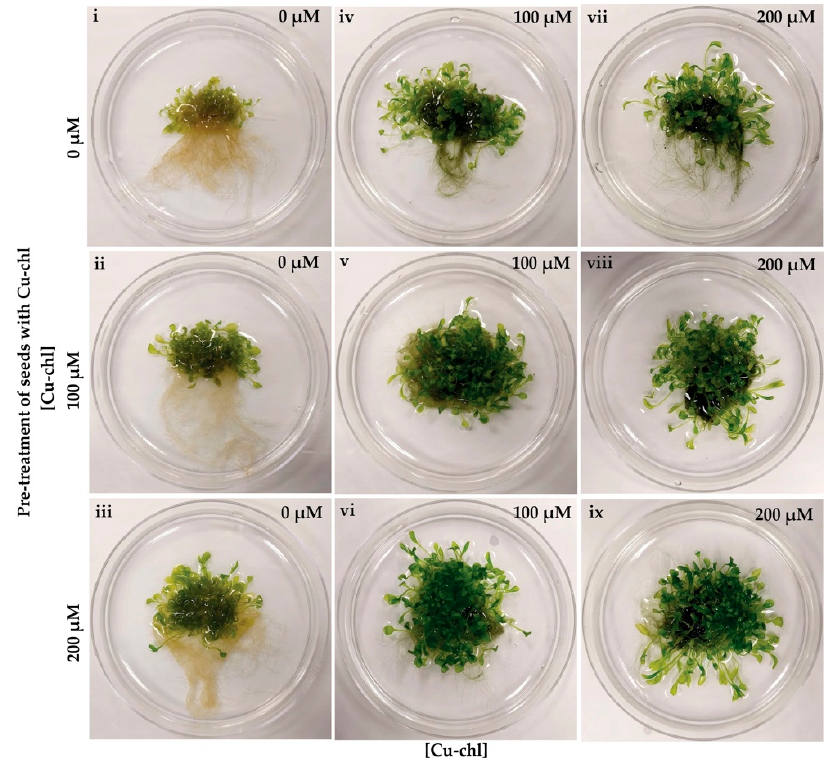
Figure 2. Paraquat induced phenotypes in Arabidopsis seedlings in the presence and absence of Cu-chl. Note bleaching on leaves, and stunted leaf growth ( i ) in the absence of Cu-chl. Cu-chl pre-treatment only ( ii , iii ), and pre-treatment and supplement ( iv – ix ) in the media showed improved growth and less bleaching of Arabidopsis seedlings.